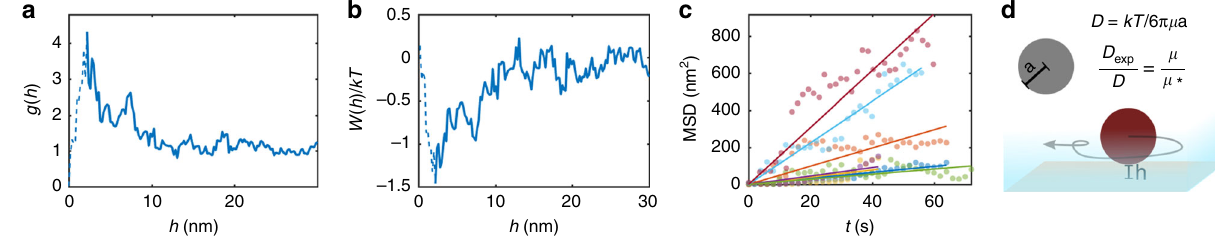
Fig. 4 Analysis of nanoparticle interactions and diffusion. a Radial distribution function, b W ð h Þ = kT ¼ (cid:2) ln g h ð Þð Þ . Note that the decrease in g(h) at small h values is not due to a short-range repulsion, but rather to the particle attachment events that rapidly remove any particles from this region, as well as the inability to sample probability at h = 0 , c mean squared displacement of diffusing particles. Color markers correspond to different example particles. d Scheme depicting signi fi cantly reduced particle diffusivity near the TEM